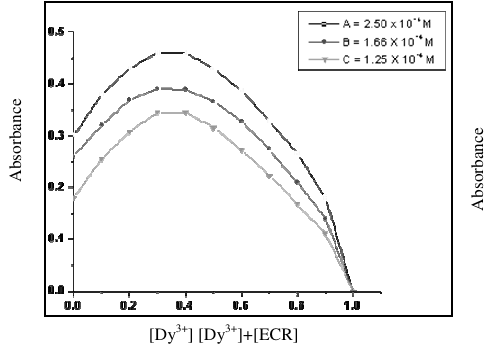
Figure 3(b). Curves of Job’s method of ternary complex shows composition of